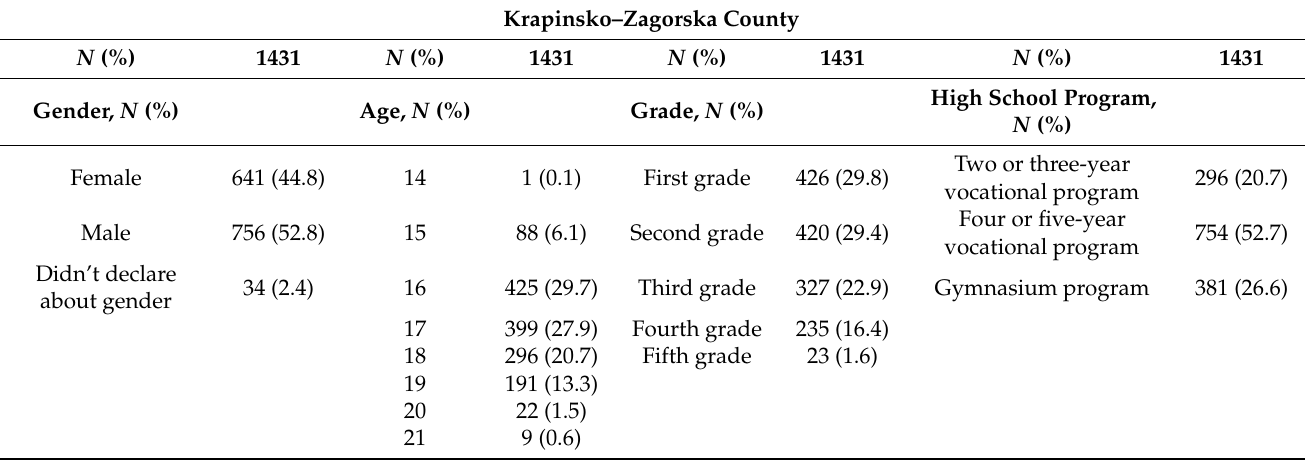
Table 2. Socio-demographic characteristics of participants (sample—students participating in SLA) ( N =